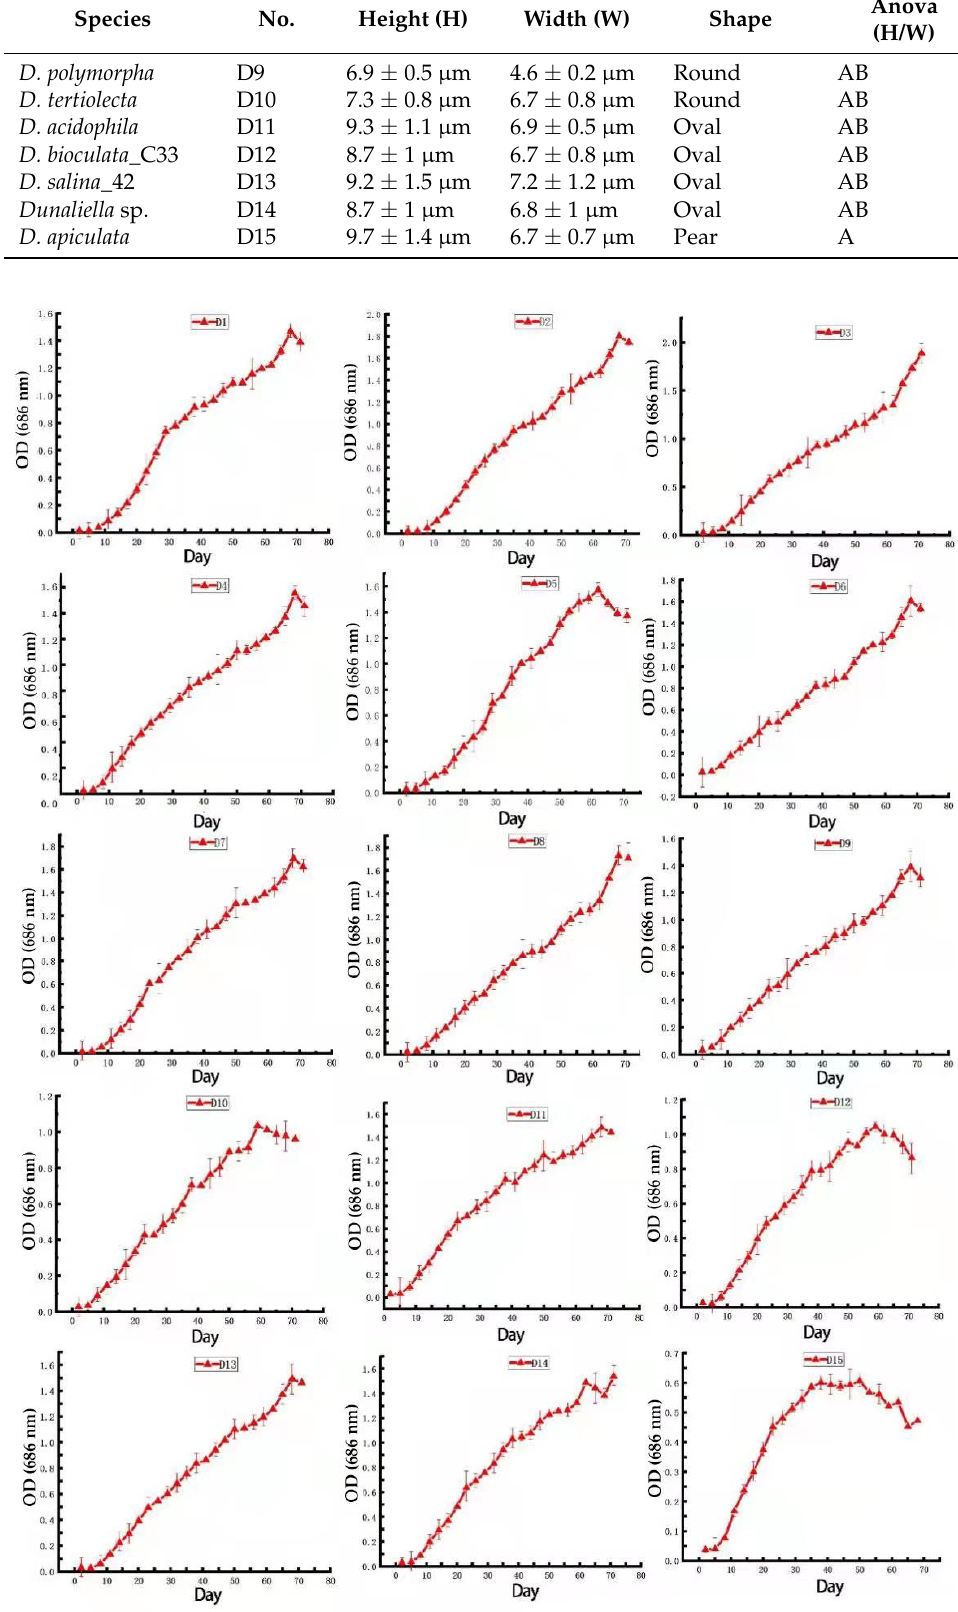
Figure 3. Growth changes in the 15 Dunaliella species. 3.2. Comparison of Photosynthetic Pigment Contents and Chlorophyll Fluorescence Parameters Supplementary Figures 1–3, respectively, show the changes in chlorophyll a , chlo- rophyll b , and carotenoid contents in the 15 Dunaliella species. All three pigments in- creased over time. Among them, the chlorophyll a , chlorophyll b , and carotenoids of D8 are the largest (chlorophyll a content is 19.58 mg/mL, chlorophyll b content is 10.3 mg/mL, carotenoid content is 6.4 mg/mL). Compared with 14 other Dunaliella strains, D15 has the lowest chlorophyll and carotenoid content (chlorophyll a content is 7.30 mg/mL, and the carotenoid content is 1.881 mg/mL). It shows that the chlorophyll and carotenoid synthesis in different Dunaliella varies, but the overall change trend has gradually accu-